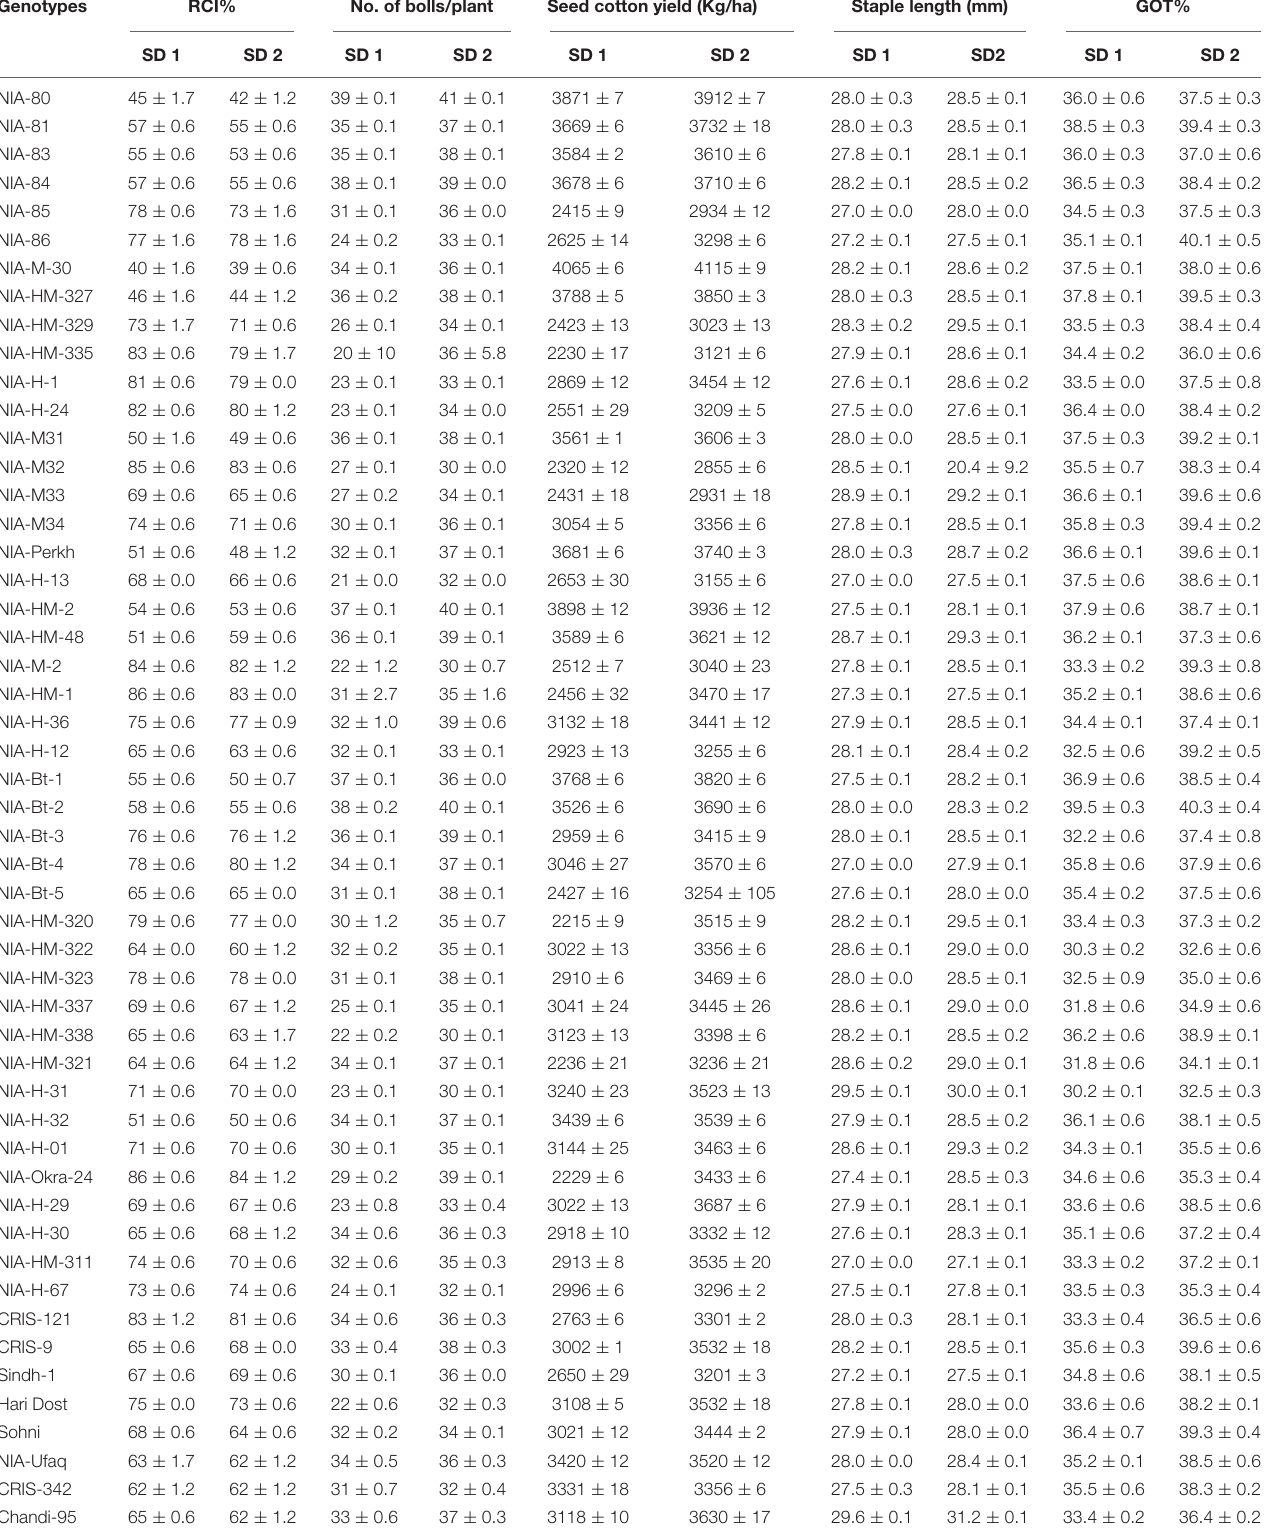
TABLE 1 | Mean performance of 58 cotton genotypes for relative cell injury percentage (RCI%), yield, and fiber traits. Genotypes RCI% No. of bolls/plant Seed cotton yield